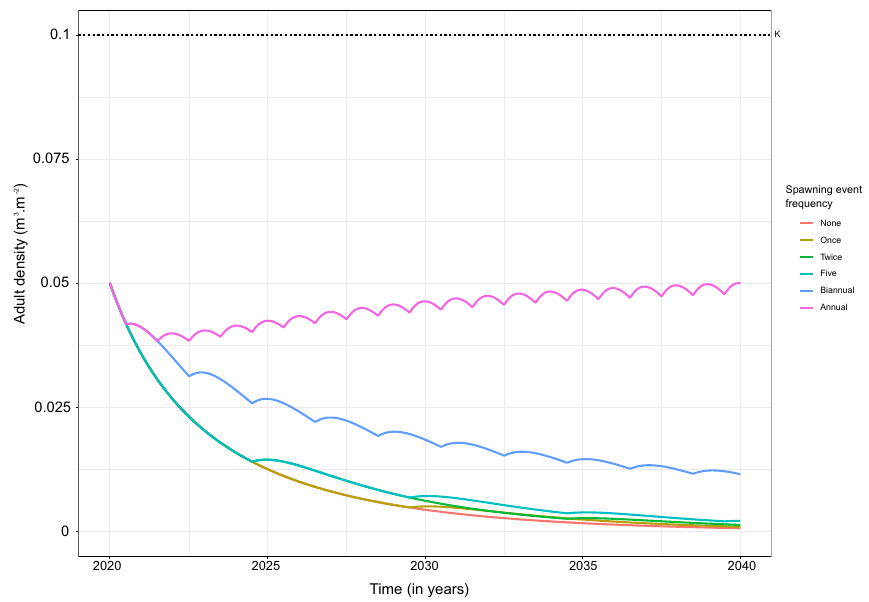
3 m − 2 Figure 1. Adult density of the wild population ( m ) over time with no spawning event ( None —orange line), one spawning event after 10 years ( Once —ocher line), two spawning events after 5 and 15 years ( Twice — green line), spawning events every 5 years ( Five —clear blue line), biannual spawning events ( Biannual — purple line), and annual spawning events ( Annual —pink line). The wild population is assumed to be initially 3 m − 2 3 m − 2 established at a density A 0 = 0.05m and the carrying capacity at K = 0.1m (black dotted